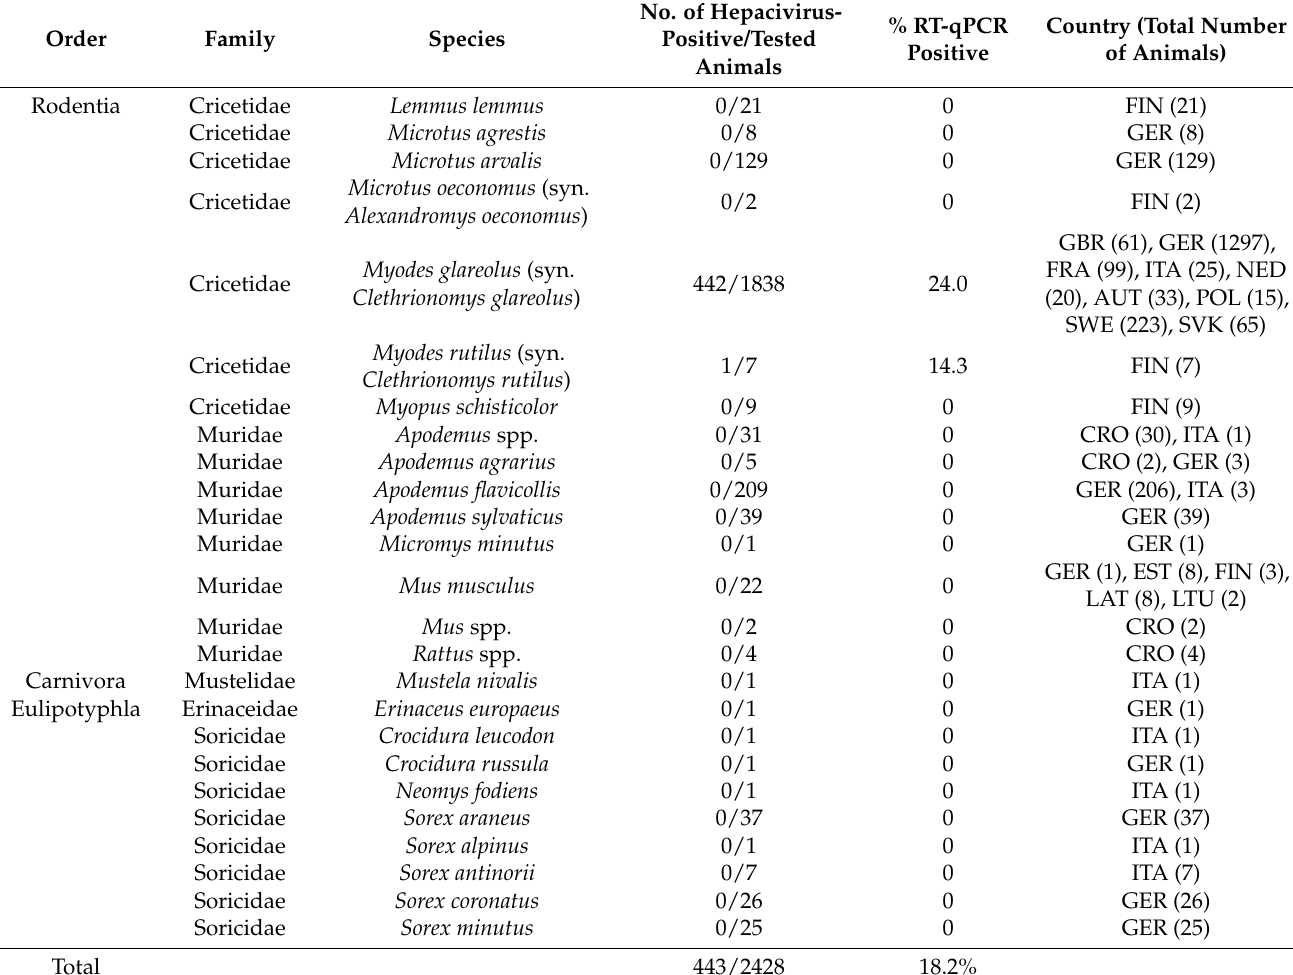
Table 1. Overview of mammal species screened for presence of BvHV RNA and RT-qPCR results.